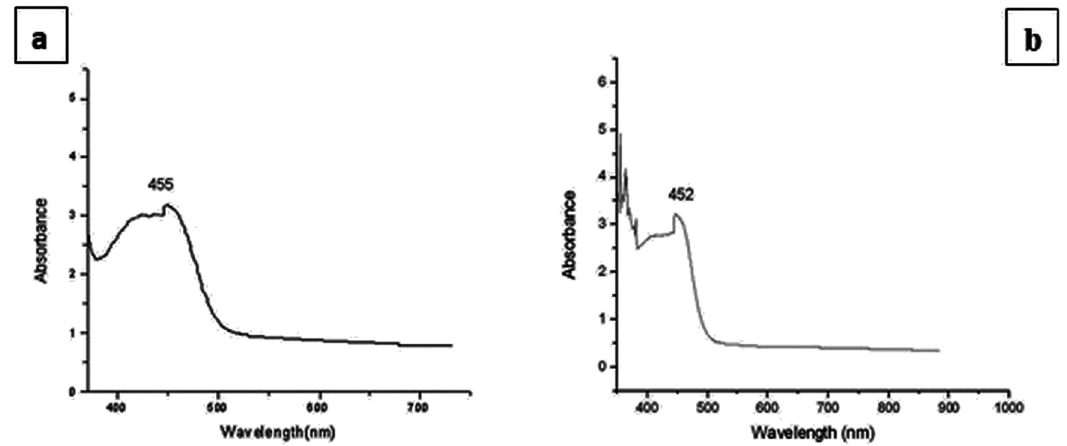
Figure 3: UV - vis spectrum of Ag - NPs: ( a ) from leaf and ( b ) from bark.